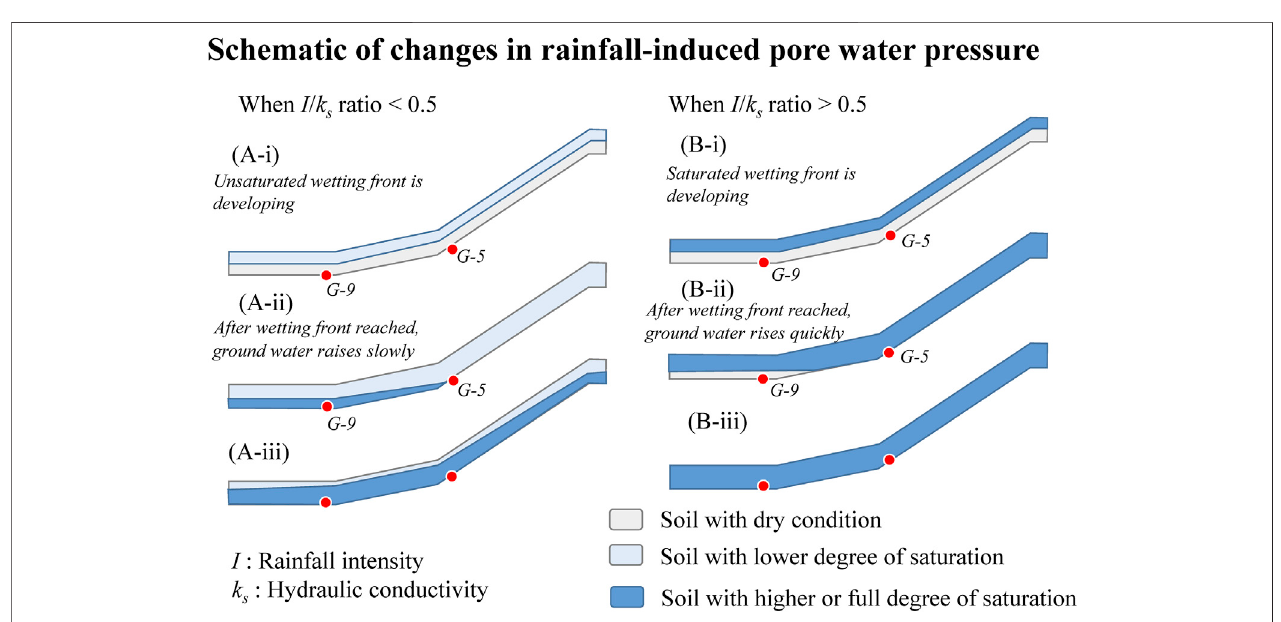
FIGURE 8 | Schematic of changes in rainfall-induced pore water pressure.